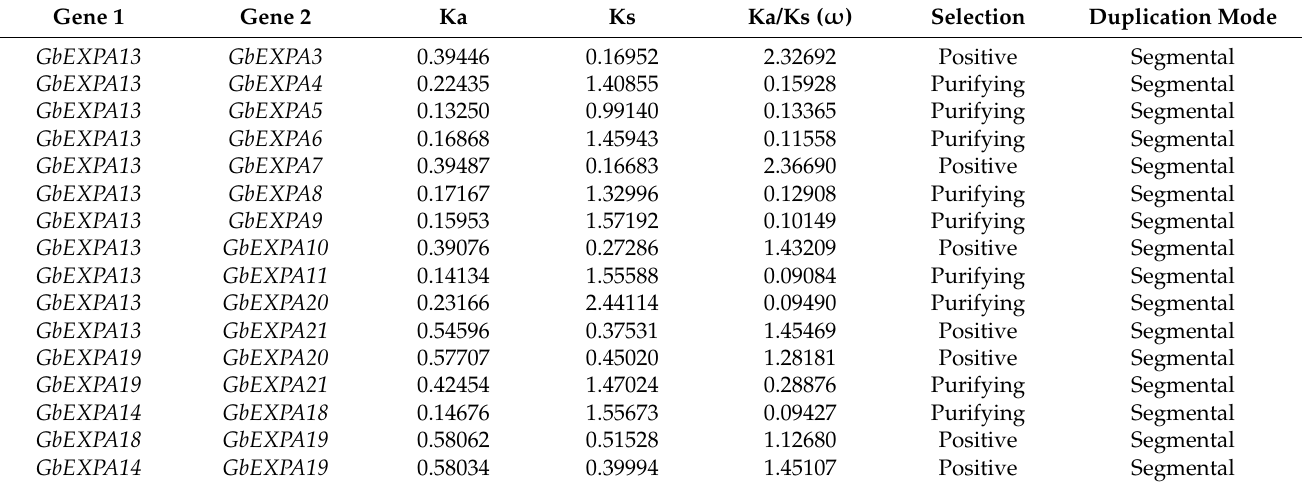
Table 1. Ka (nonsynonymous), Ks (synonymous), and Ka/Ks ratios of duplicated GbEXPs in